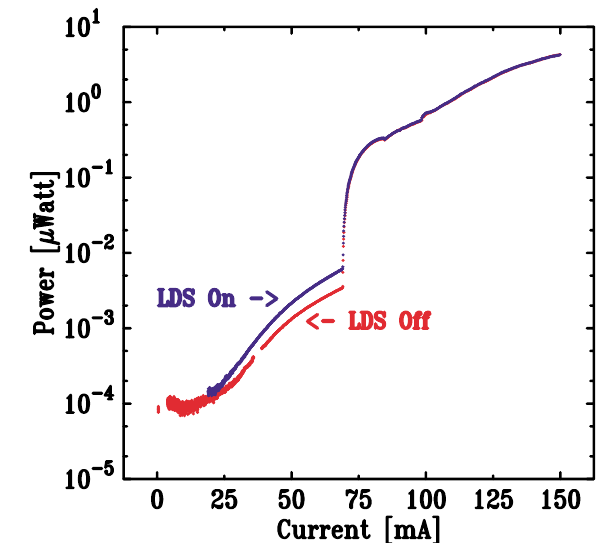
FIG. 10. (Color) The average power for the A peak versus bunch current at an energy of 737 MeV with the LDS turned on and off.